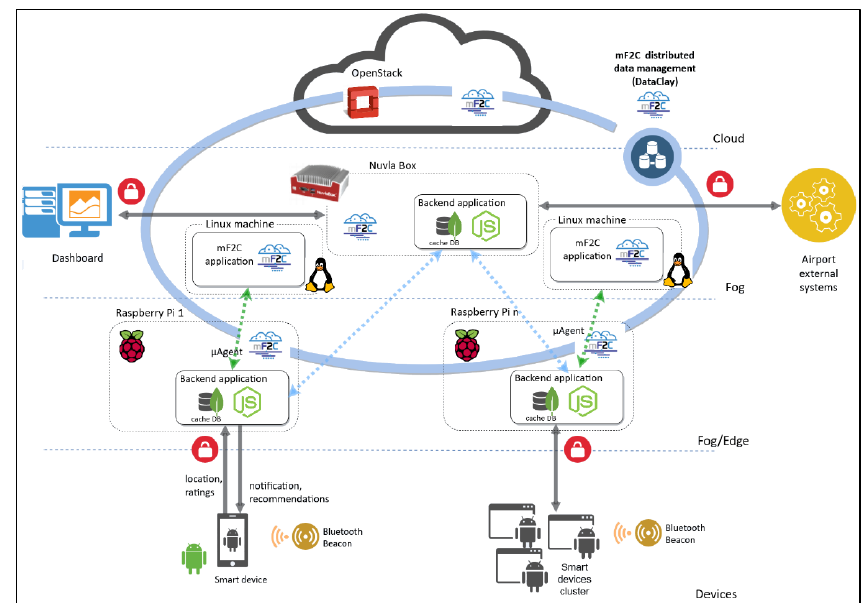
Figure 5. Smart Fog Hub